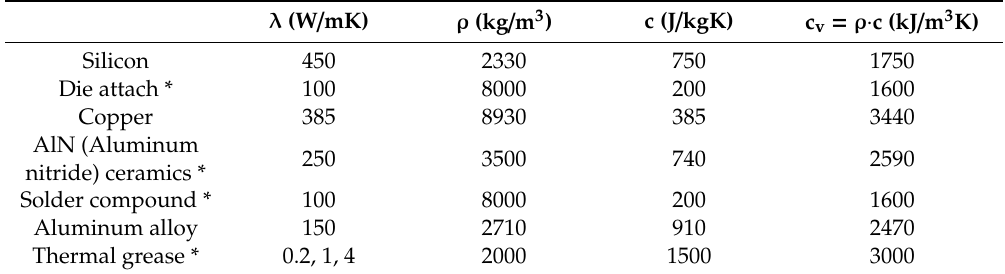
TableA1. ThermalparametersofthematerialsusedintheexampleofSection3: λ —thermalconductivity, ρ —density, c—specific heat, c V —volumetric specific heat.